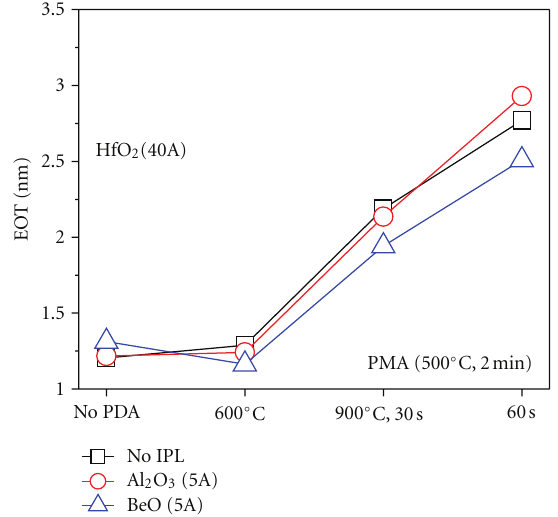
Figure 3: The change of EOT with the annealing temperature and duration for three di ff erent gate stacks.